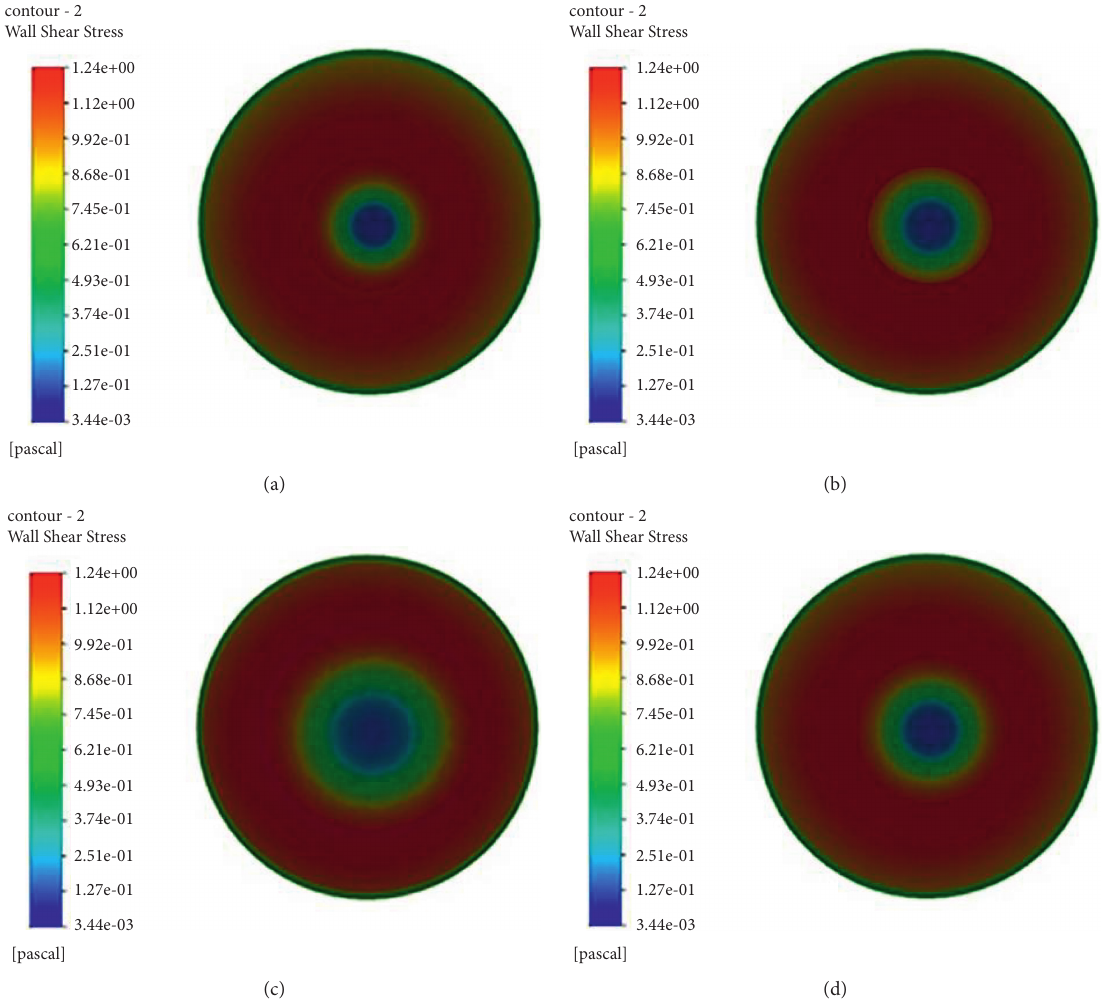
Figure 14: The shear force distribution on the blade surface with different abrasive diameters. (a) The shear force distribution on the blade surface with the abrasive diameter of 0.2 mm. (b) The shear force distribution on the blade surface with the abrasive diameter of 0.3mm. (c) The shear force distribution on the blade surface with the abrasive diameter of 0.4mm. (d) The shear force distribution on the blade surface with the abrasive diameter of